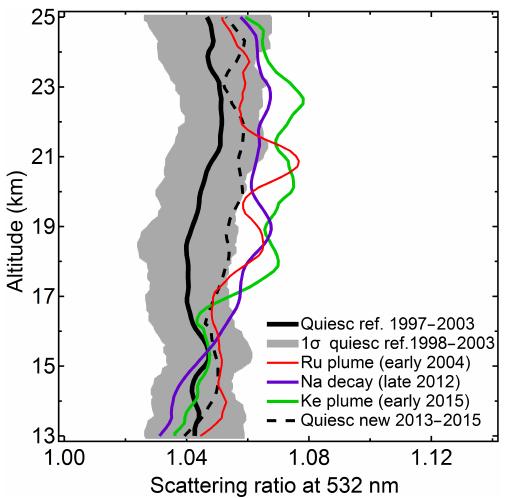
Figure 5. Vertical profiles of scattering ratio (532nm) averaged over different periods: reference quiescent period (Quiesc. ref. 1997– 2003) and its 1 standard deviation range (1 σ Quiesc. ref.); aged volcanic plumes of Ruang and Reventador (red); Nabro in late 2012 (violet); Kelud (green); post-Nabro quiescent period (Quiesc. new, black dashed). See Fig. 3 and Table 2 for details on period defini-